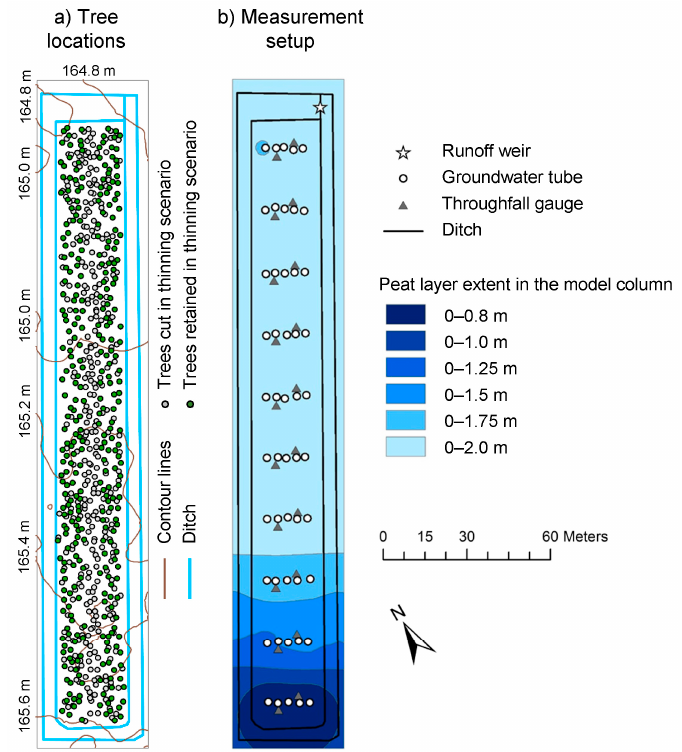
Figure 1. Tree locations and digital elevation model contour lines at 0.2-m intervals ( a ) and measurement setup with peat layer depth ( b ) in Sattasuo, northern Finland. All trees were included in the stand description scenarios and the green coloured trees were included in the forest management scenarios (for scenario definitions, see Section 2.5).